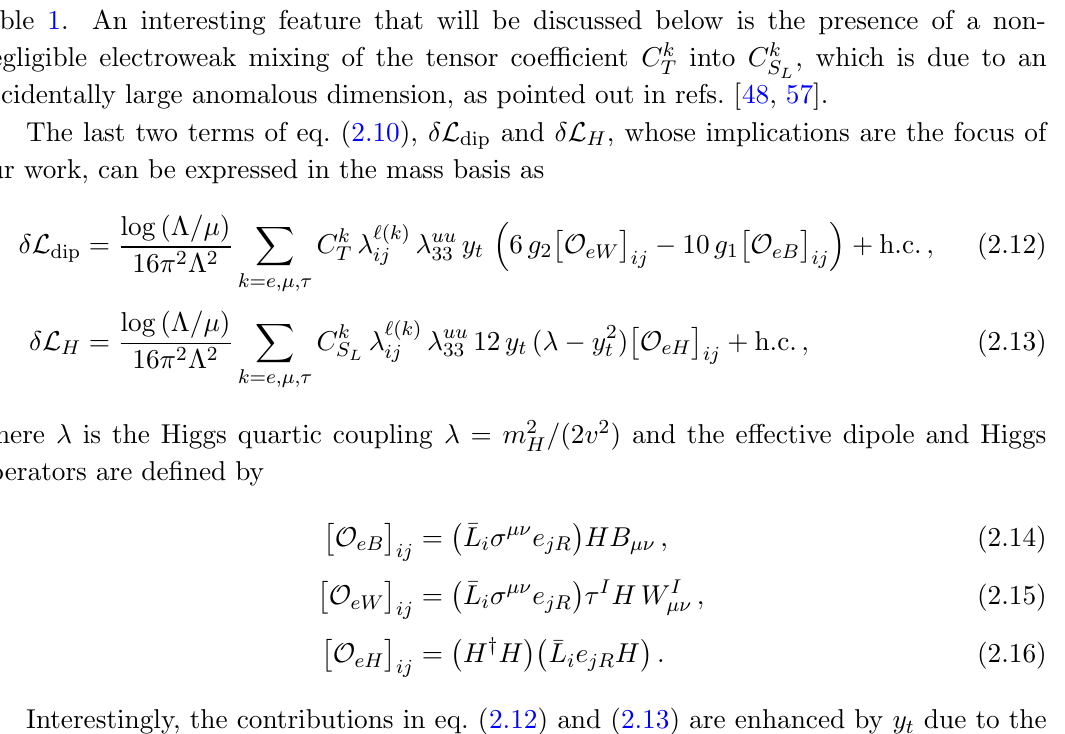
Figure 1 . Higgs coupling to charged leptons in the SM and the new contributions generated by the Lagrangian (2.2) through loop e(cid:11)ects. While the SM term is proportional to the lepton Yukawas ( y ‘ ), the NP contributions are proportional to di(cid:11)erent powers of the top Yukawa ( y t ), cf. eq. (2.13). where the operators Q SL and the corresponding Wilson coe(cid:14)cients (cid:24) SL are collected i i